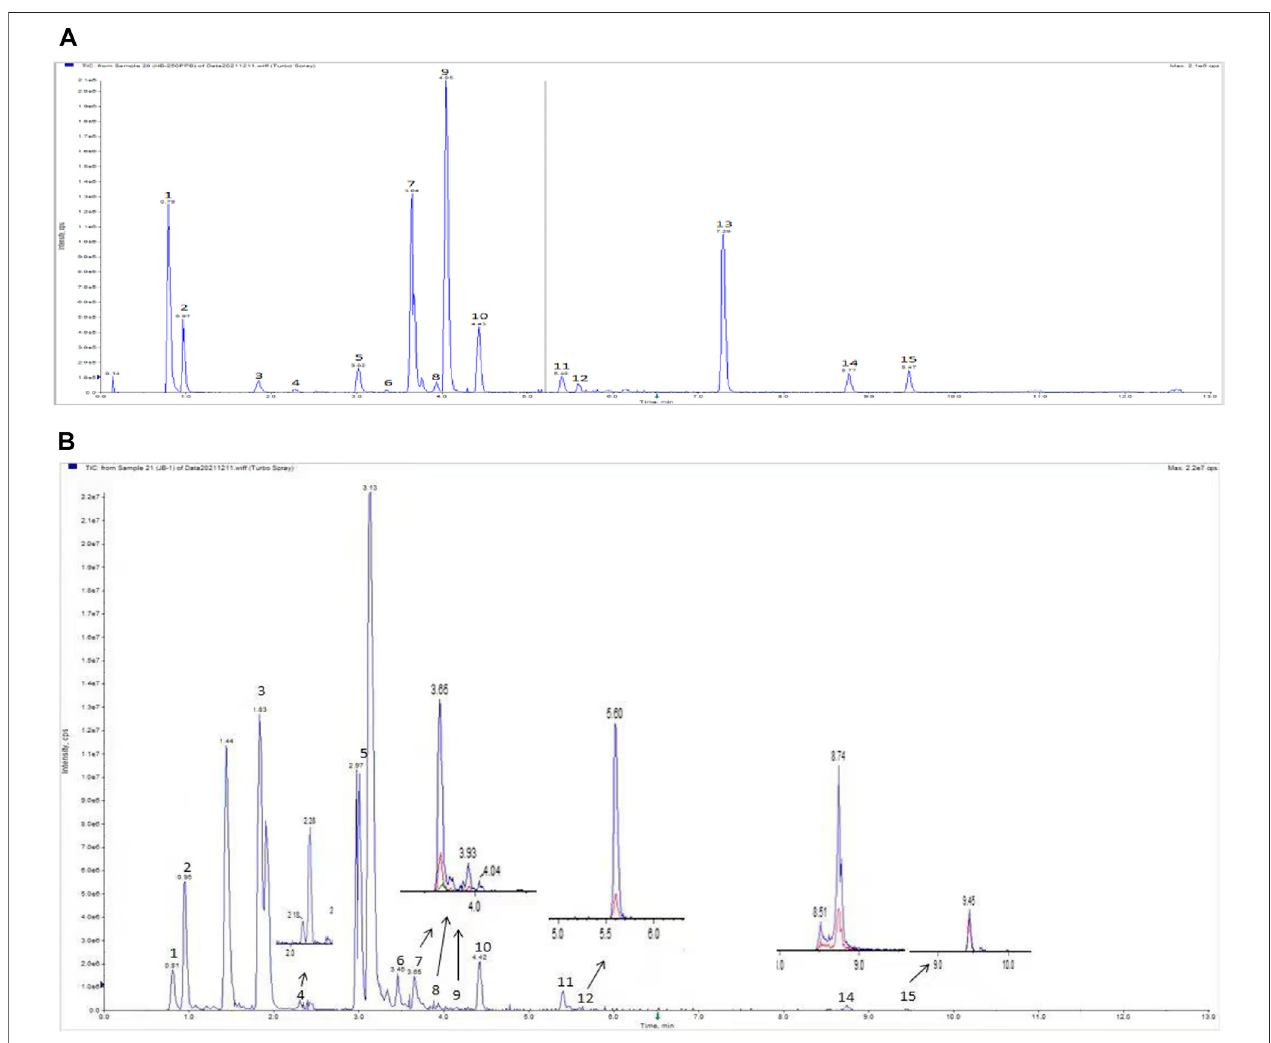
FIGURE 7 | UHPLC analysis of JBOL. A chromatogram of mixed reference standards (A) and Jinbei oral liquid (B) . UPLC conditions: column 2.1 × 100 mm, 1.7 μ m particle size. The mobile phase was composed of component A (0.1% formic acid in water) and component B (acetonitrile). The fl ow rate was 0.3 ml/min.